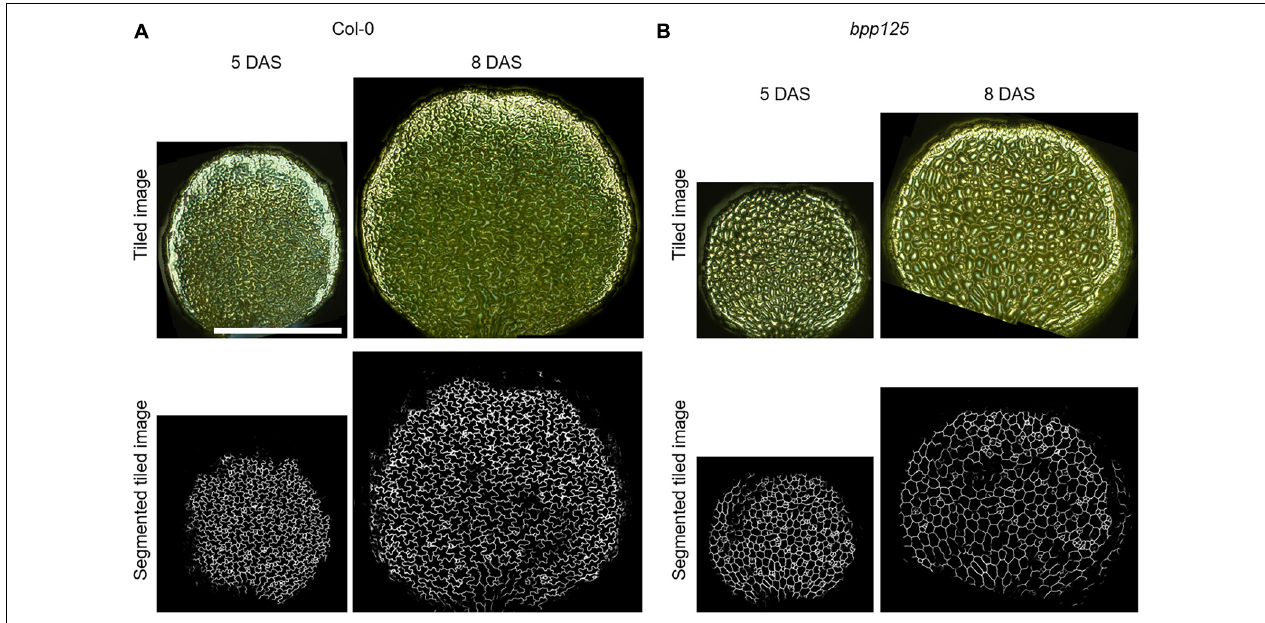
FIGURE 5 | Wide-area cotyledon surface images and the deep learning-based epidermal cell segmentation from tiled omnifocal metallographic images. Tiled omnifocal metallographic microscopic images and segmented images obtained based on deep learning of wild type (Col-0) (A) and bpp125 triple mutant (B) cotyledons. Growth was measured just after silver ink coating [5 days after sowing (DAS)] and again 3 days later (8 DAS). Scale bar indicates 1